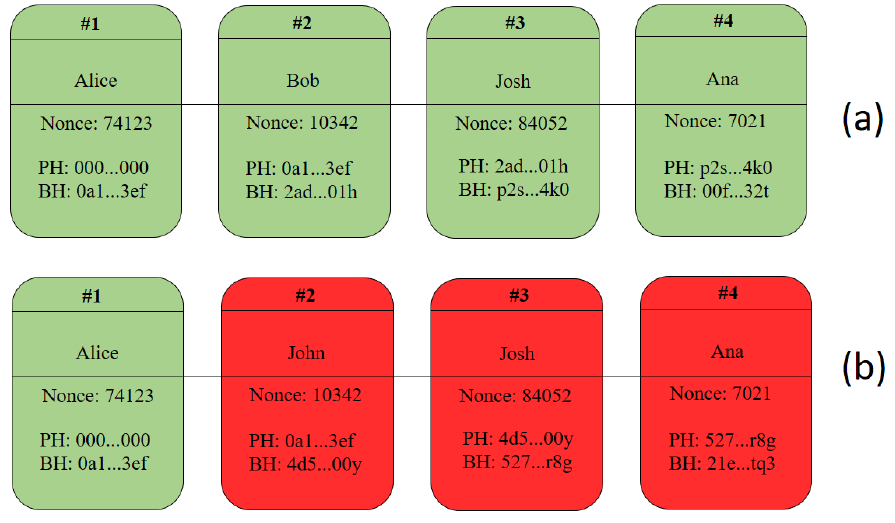
Figure 1. ( a ) Original blockchain and ( b ) Changed